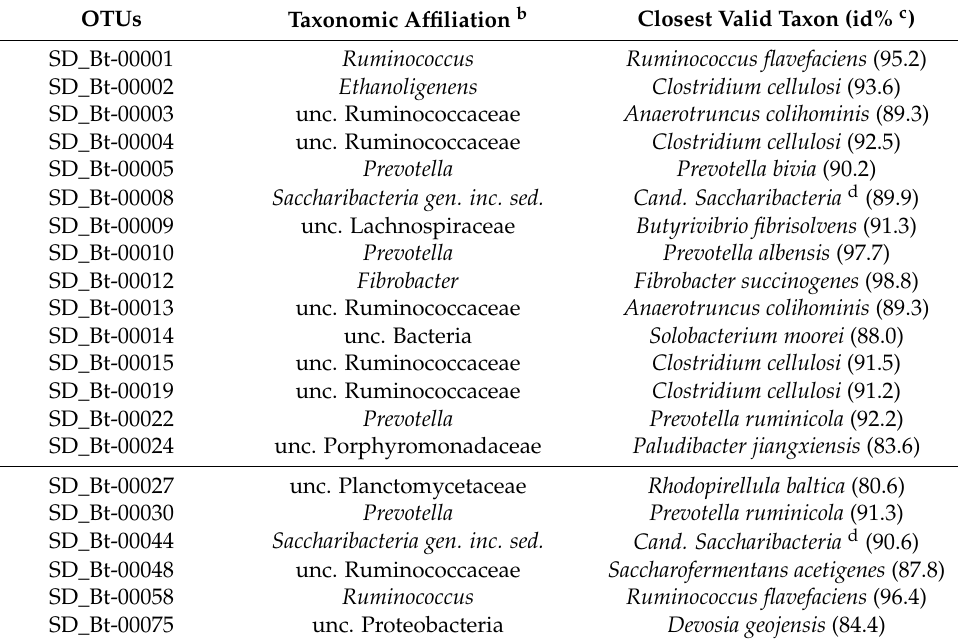
Table 3. Taxonomic affiliation of the most abundant a OTUs from selection with cellulose.